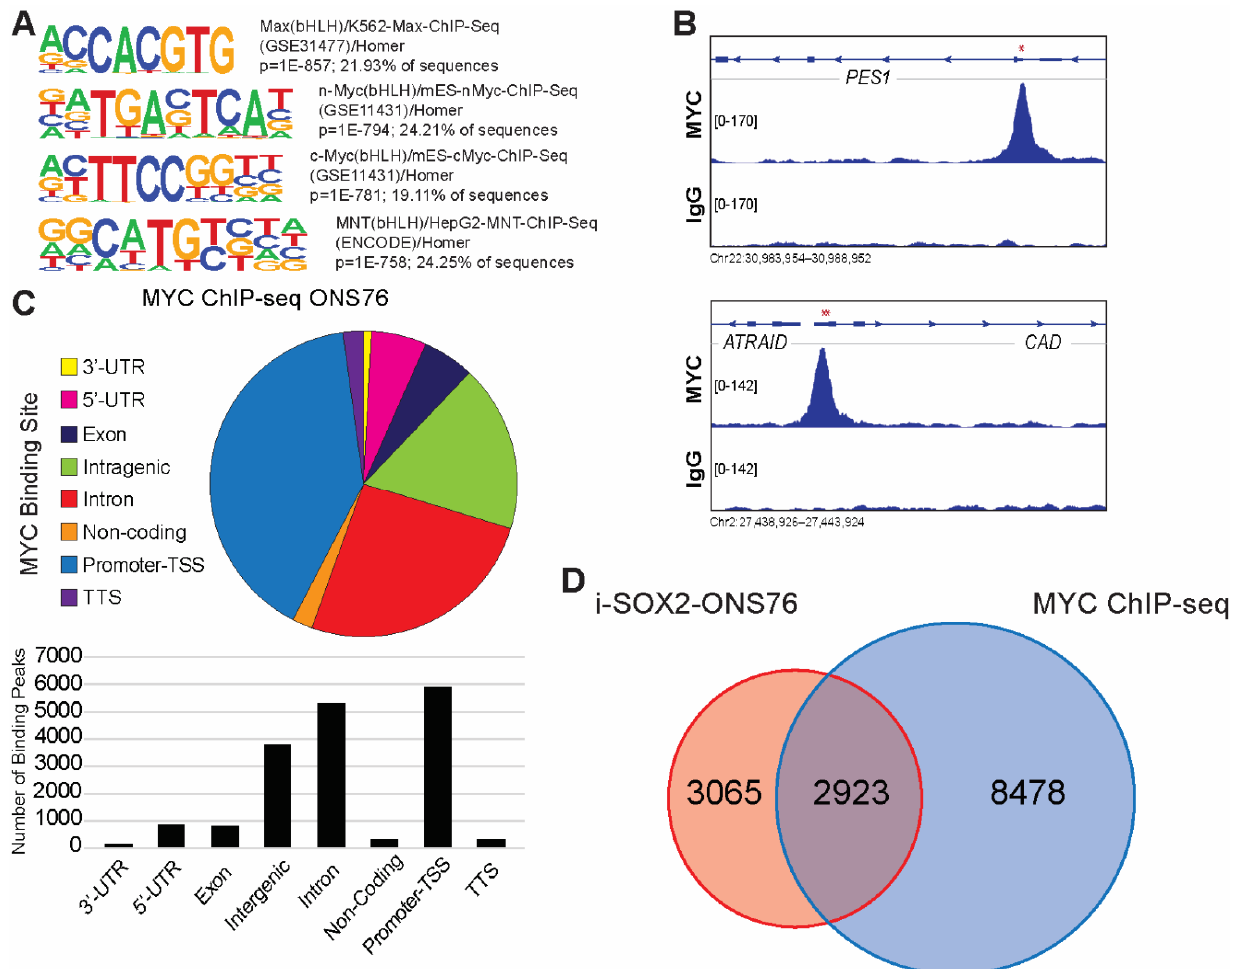
Figure 3. ChIP-seq analysis of MYC binding peaks in ONS76 cells. ( A ) Motif analysis for MYC- binding sites in ONS76 cells. Significance values and percentage of ChIP-seq peaks containing the motif are indicated. ( B ) IGV screenshot of representative ChIP-seq peaks for MYC in ONS76 cells. PES1 contains an MYC-binding peak in a promoter/TSS region and CAD is bound near the TTS. Red asterisks indicate the position of E-boxes within the binding peaks. ( C ) Distribution of MYC binding peaks across regions of associated genes. ( D ) Venn diagram comparing i-SOX2-ONS76 DEGs and genes with associated MYC binding peaks.